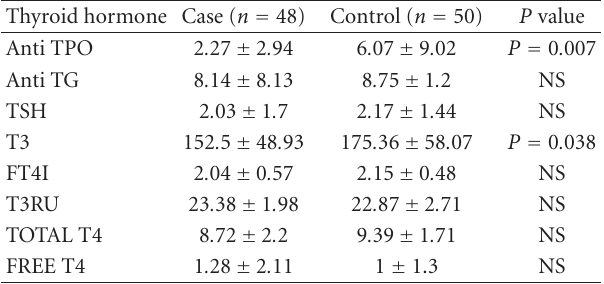
Table 2: Average levels of thyroid hormones and thyroid auto antibodies in cases and controls. Thyroid hormone Case ( n = 48) Control ( n =